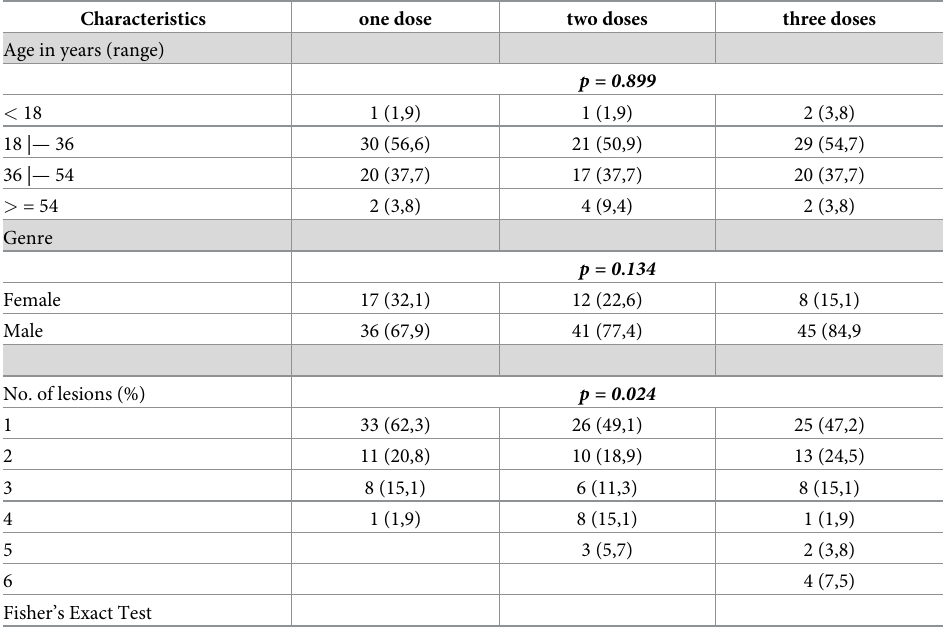
Table 1. Baseline characteristics of the included patients with ACL in Manaus in